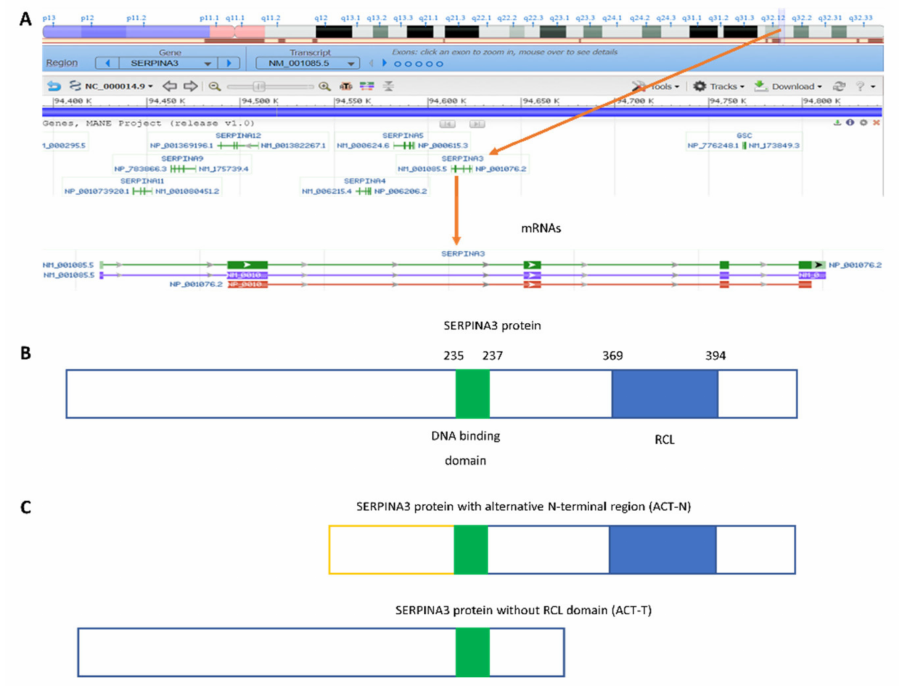
Figure 1. SERPINA3 (serine protease inhibitor A3) gene: ( A ) chromosomal localization and canonical mRNA forms based on NCBI Genome data (https://www.ncbi.nlm.nih.gov/genome/gdv/browser/ gene/?id=12, accessed on 21 December 2022); ( B ) scheme of canonical SERPINA3 protein; ( C )